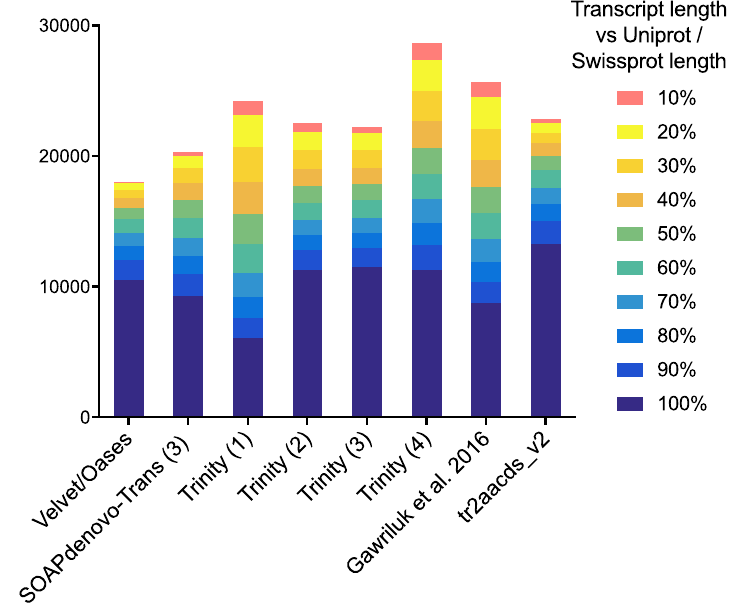
Figure 10. Assessing the number of full-length protein-coding transcripts within transcriptome assemblies, with UniProtKB/SwissProt BLAST hits (e-value ≤ 1 × 10 − 20 ) categorised by length of alignment (nucleotides) with the UniProtKB/SwissProt reference transcript. Transcripts are considered ‘full-length’ if they are > 90% of the reference transcript length. SOAPdenovo-Trans (3): moderate filtering of poor quality read pairs; Trinity (1): light filtering of poor quality read pairs, combined with in silico normalization; (2): moderate filtering of poor quality read pairs; (3): light filtering of poor quality read pairs, combined with SEECER error correction; (4) Trinity v2.3.2 after moderate filtering of poor quality read pairs; tr2aacds merged assemblies (v1): pre-v2.3.2 Trinity; (v2) including v2.3.2 Trinity